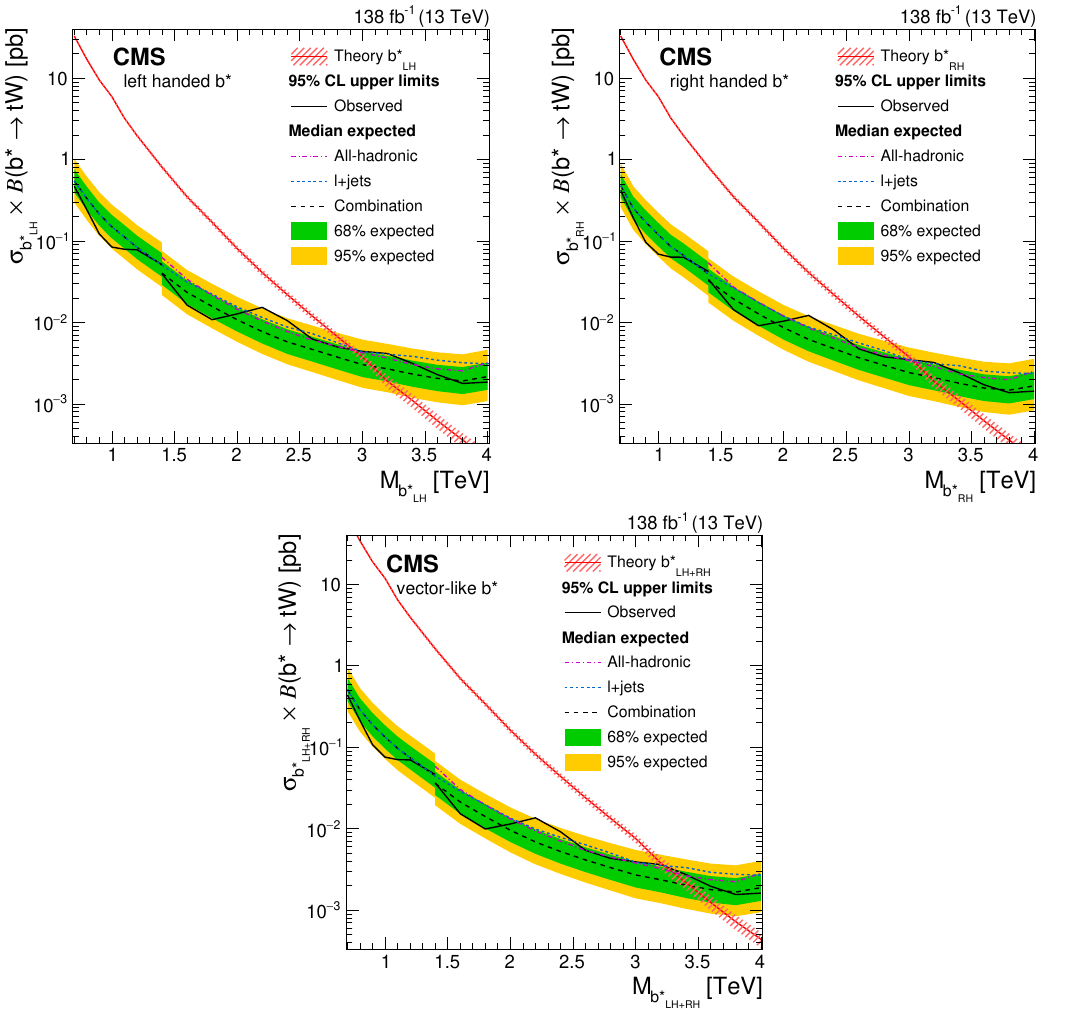
Figure 3 . Upper limits on the product of production cross section and branching fraction of the left-handed (upper left), right-handed (upper right) and vector-like (lower) b ∗ hypotheses at 95% CL. Colored lines show the expected limits from the ‘ +jets (dotted) and all-hadronic (dash-dotted) channels, where the latter start at b ∗ masses of 1.4 TeV. The observed and expected limits from the combination are shown as solid and dashed black lines, respectively. The green and yellow bands show the 68 and 95% confidence intervals on the combined expected limits. The theoretical cross sections are shown as the red lines, where the uncertainties due to missing higher orders are depicted by shaded